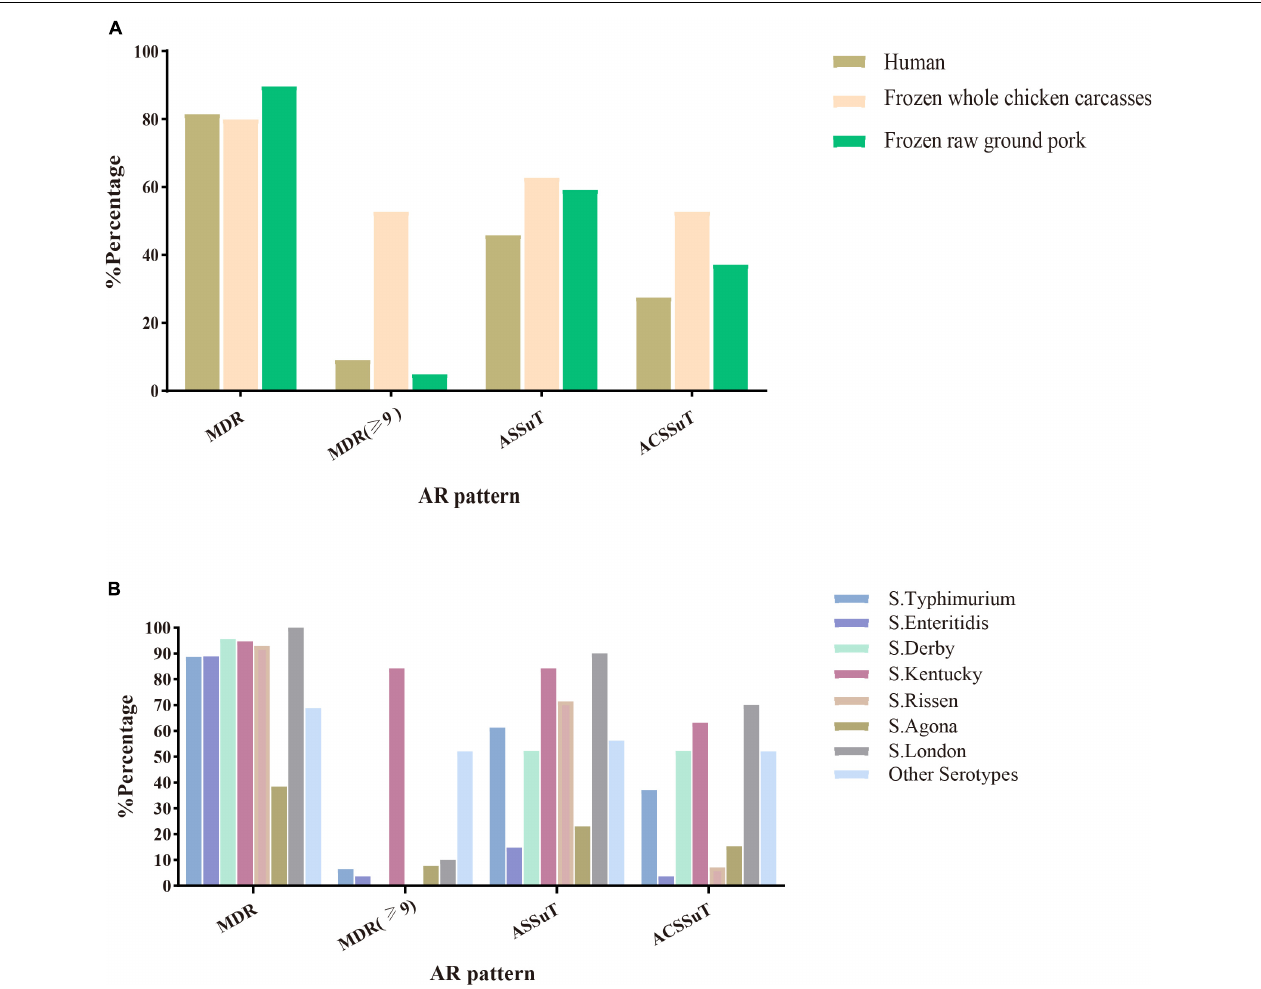
FIGURE 1 | Antimicrobial susceptibility patterns (MDR, ASSuT, and ACSSuT) in 216 Salmonella isolates from different sources (A) and serotypes (B) . MDR, multidrug-resistant; MDR ( ≥ 9): ≥ 9 antimicrobial classes; ASSuT, ampicillin, streptomycin, sulfonamides, and tetracycline; ACSSuT, ampicillin, chloramphenicol, streptomycin, sulfonamides, and